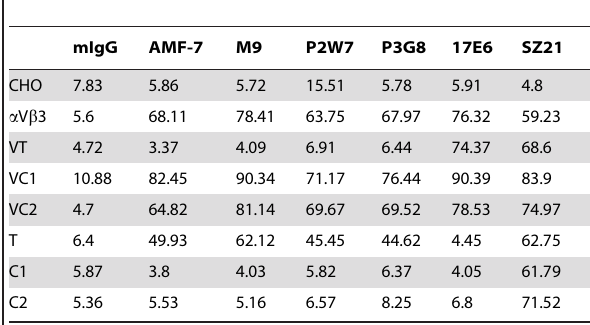
Table 2. MAb binding to cells expressing domain-swapping